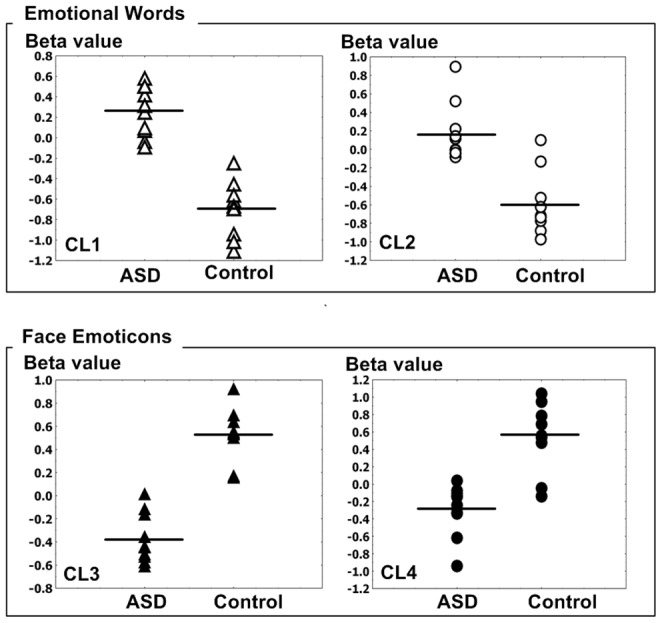
The beta values of brain activity in response to emotional words / facial emoticons.Cluster1 (CL1, unfilled triangle): right temporal lobe, fusiform gyrus, Brodmann area 20; Cluster2 (CL2, unfilled circle): Right Cerebrum,Occipital Lobe,Fusiform Gyrus, Right Cerebrum, Occipital Lobe, Inferior Occipital Gyrus, Right Cerebellum, Posterior Lobe, Cluster3 (CL3, filled triangle): Right Cerebrum,Temporal Lobe, Middle Temporal Gyrus, Cluster4 (CL4, filled circle): Right Cerebellum, Posterior Lobe, Right Cerebrum,Occipital Lobe, Fusiform Gyrus.